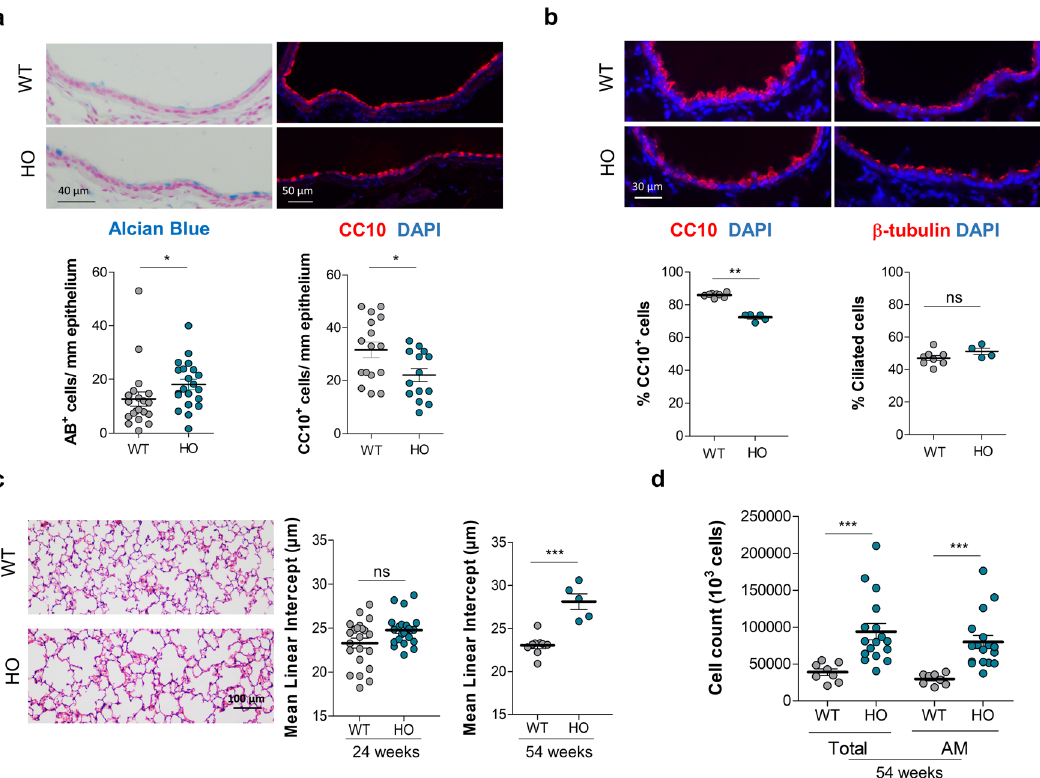
Fig. 2 COPD-like phenotype in α 5SNP mice. a Quanti fi cation of mucus-producing cells (Alcian Blue + , n = 20 WT and n = 21 HO mice), and Club cells (CC10 + , n = 16 WT and n = 14 HO mice) in proximal airways for HO (blue) and WT (gray) mice. b Quanti fi cation of Club cells (CC10 + , n = 8 WT and n = 5 HO mice), and ciliated cells ( β -tubulin + , n = 8 WT and n = 4 HO mice) in distal airways for HO (blue) and WT (gray) mice. c Quanti fi cation of mean linear intercept (MLI) for HO (blue) and WT (gray) 24 weeks-old (wo) mice ( n = 22 WT and n = 22 HO mice) and 54 wo mice ( n = 9 WT and n = 5 HO). d Total cell number and alveolar macrophages (AM) in BALF from HO ( n = 17) compared to WT ( n = 8) 54 wo mice. a – d Data are expressed as mean ± SEM. For statistical analyses, values are compared to the appropriate control. * p < 0.05; ** p < 0.01; *** p < 0.001 (Mann – Whitney two-sided